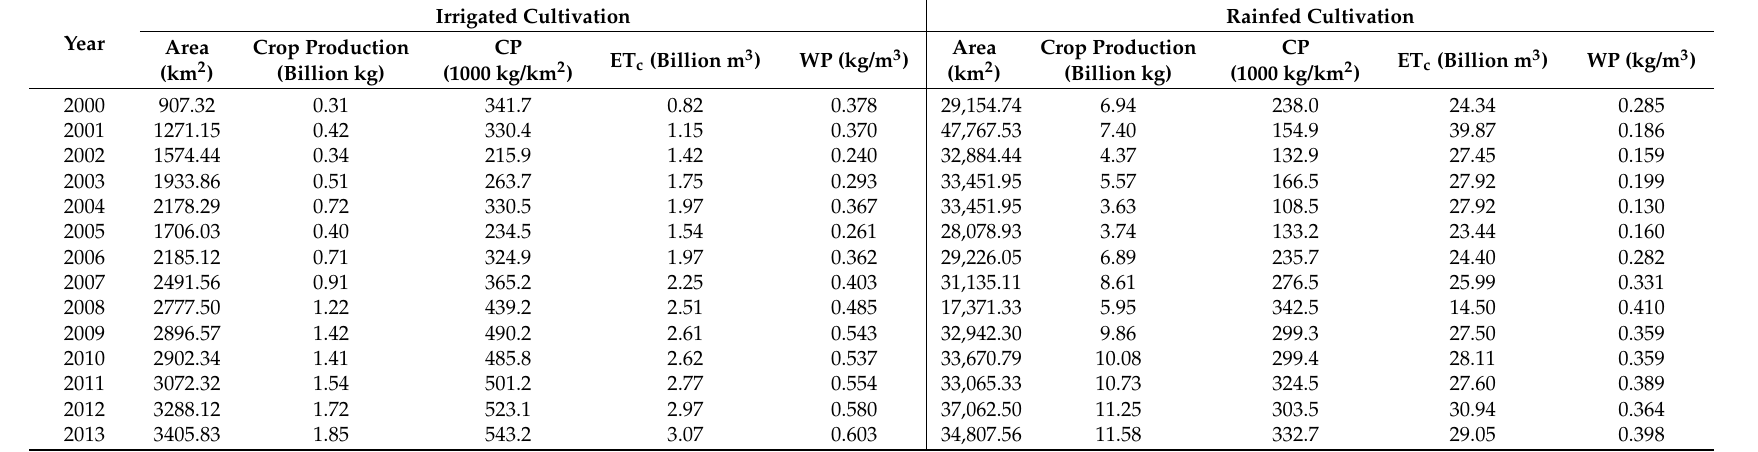
Table 1. Comparison of water productivity between rainfed and irrigated systems in